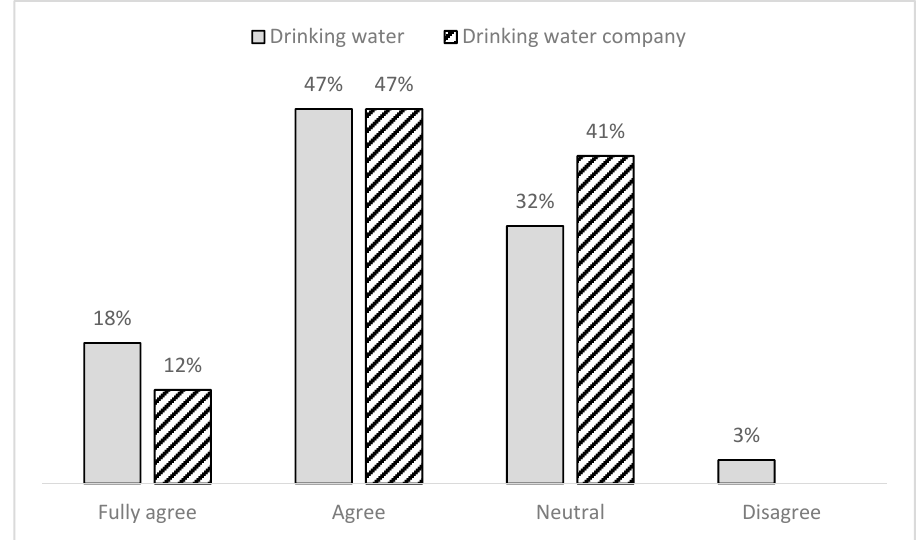
Figure 4. Impact on confidence (answer to the statement ‘As a result of my participation, the level of confidence in drinking water quality/the drinking water company has increased’).